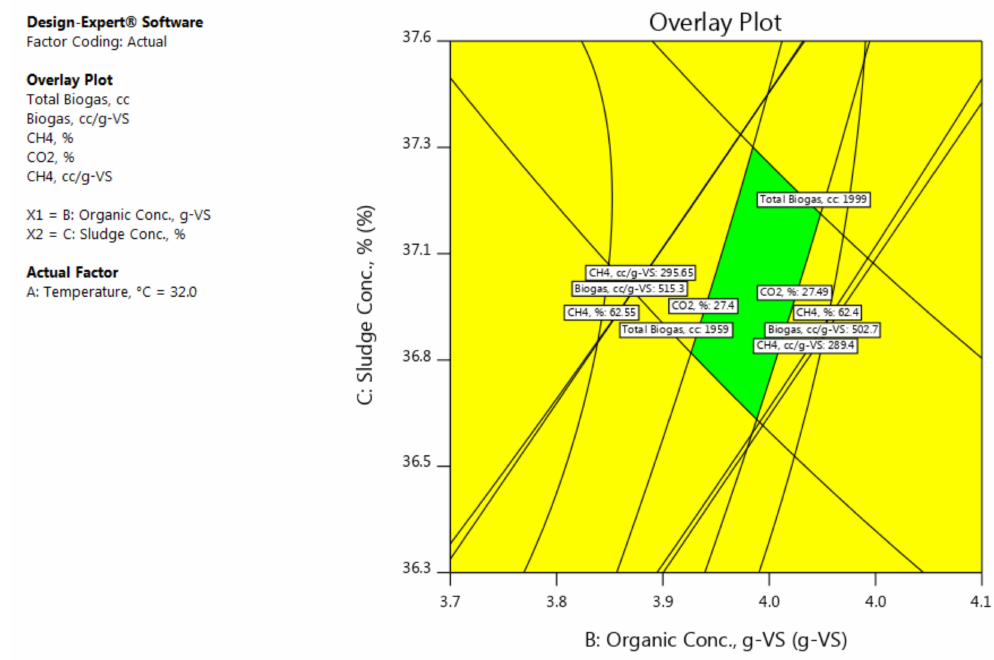
Figure 13. An overlay plot illustrating the optimum biogas based on the 3rd criterion